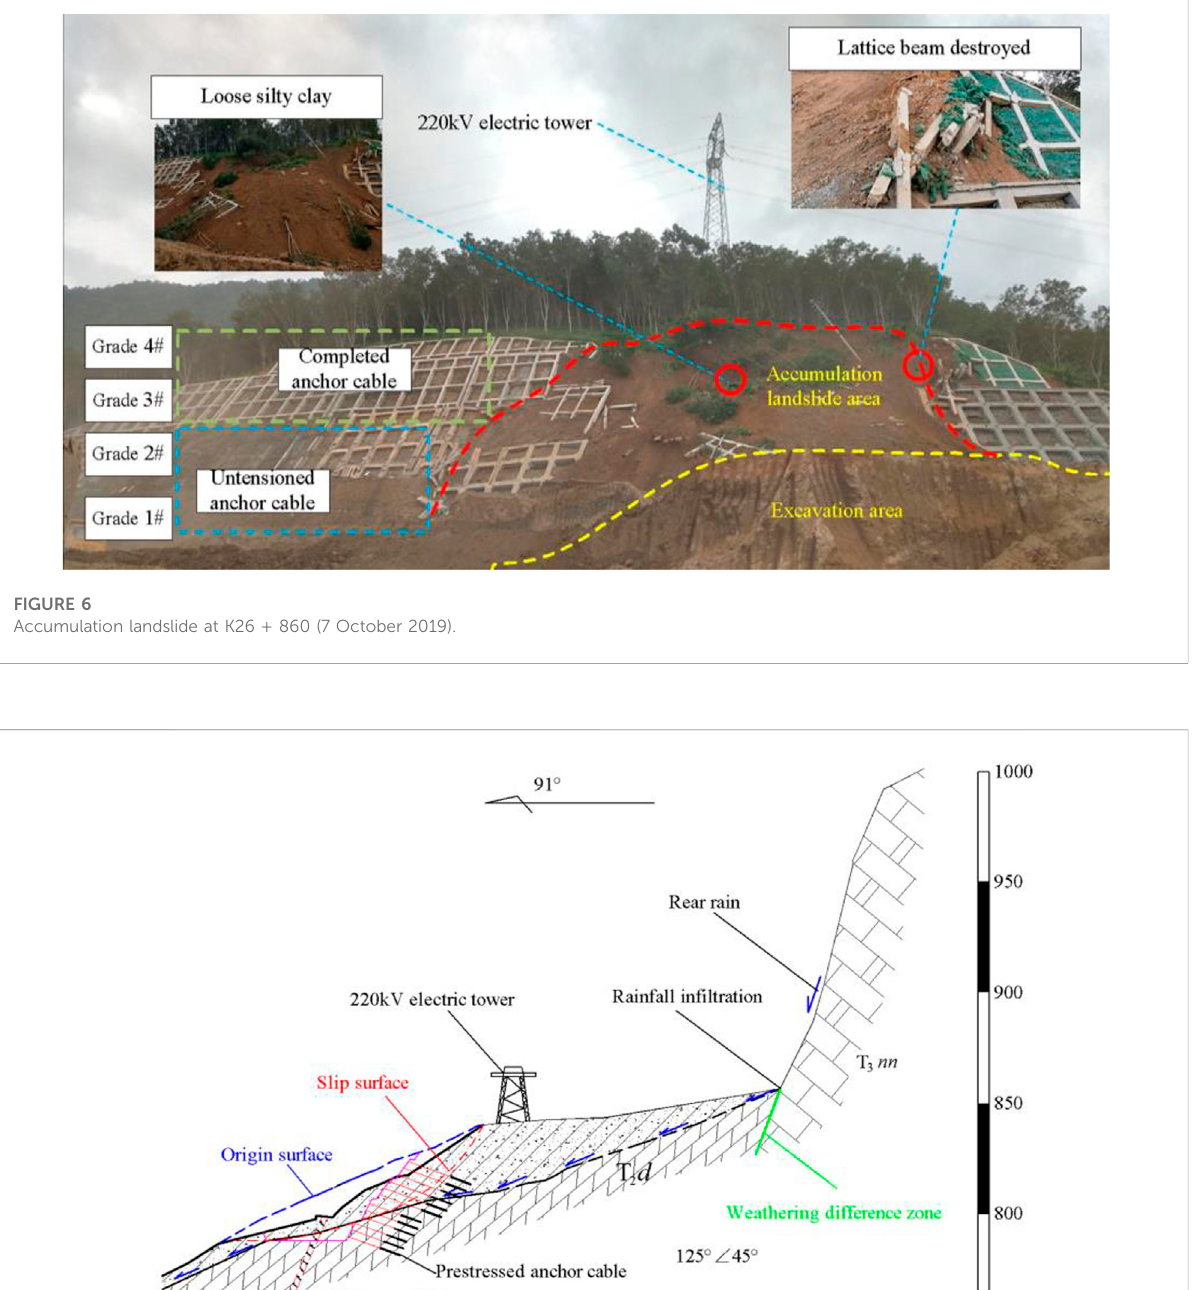
calculation results show that after completion of grade 4#, the approximately connected plastic zone distributed from the bottom to the top appeared. After completion of grade 2#, the plastic zone